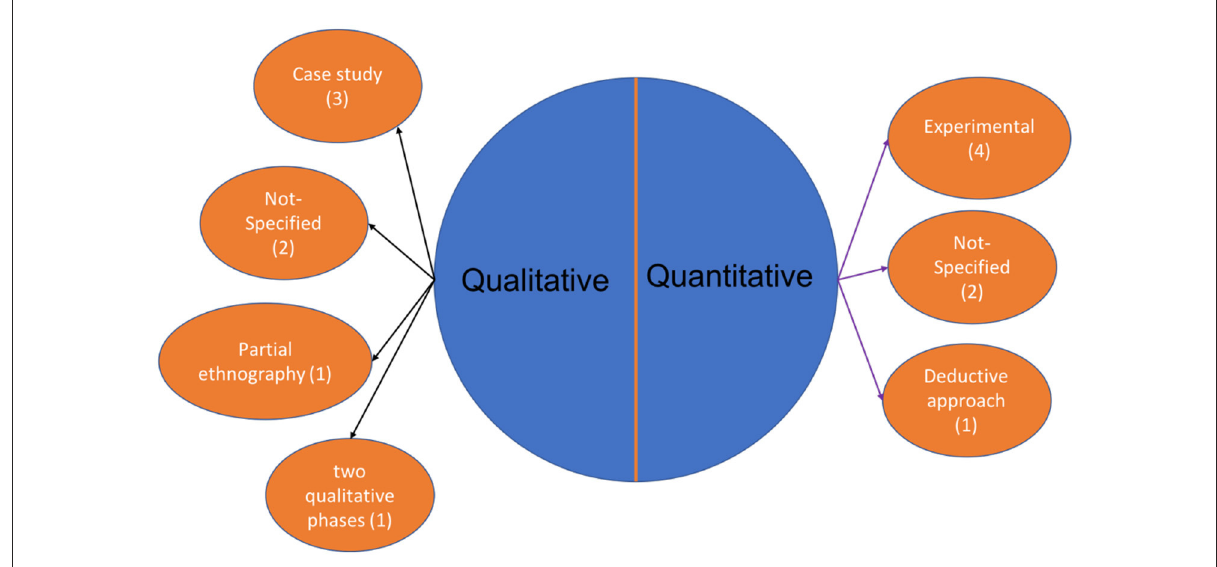
FIGURE2 The distribution of method and design.